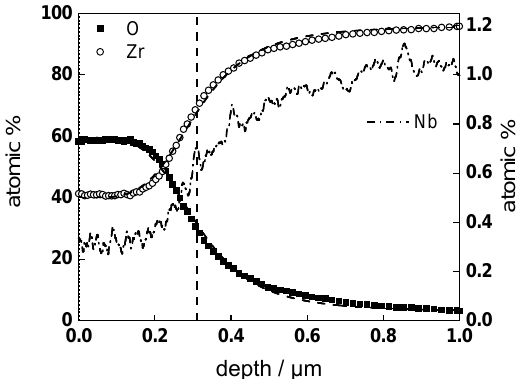
Figure 8. Elemental composition profile of the oxide on formed for 360 h in WWER coolant without LiOH at 300 °C on ex-situ pre-hydrogenated material. Dashed lines show sigmoidal regression of O and Zr profiles to estimate the position of the alloy/oxide interface (shown by vertical line).